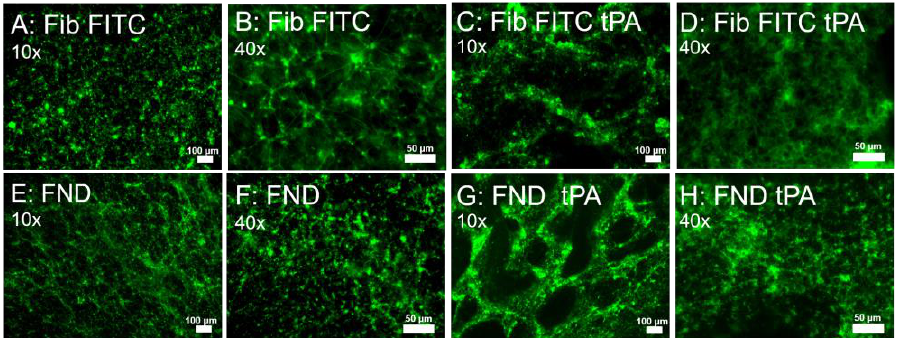
Figure 4. Epifluorescence microscopy examining fibrinogen labeled with FITC or FND in clot 1 h after formation before and after exposure to tPA: Clot containing fibrinogen-FITC without tPA exposure ( A , B ) and with tPA exposure ( C , D ) at magnifications (10 × and 40 × , respectively). Clot containing fibrinogen-bio with FND (green NVN)-avidin without tPA exposure ( E , F ) and with tPA exposure ( G , H ) at magnifications 10 × and 40 × , respectively. Scale bars are 100 um for 10 × and 50 µ m for 40 × . Ex/Em: 470/488LP.